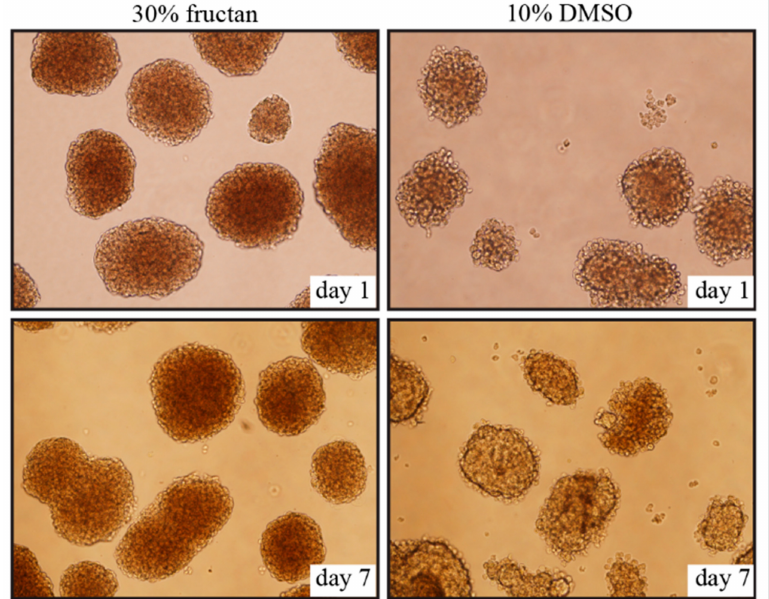
Figure 2. Morphology of the islets cryopreserved in 30% fructan or 10% DMSO after 1 day and 7 days.